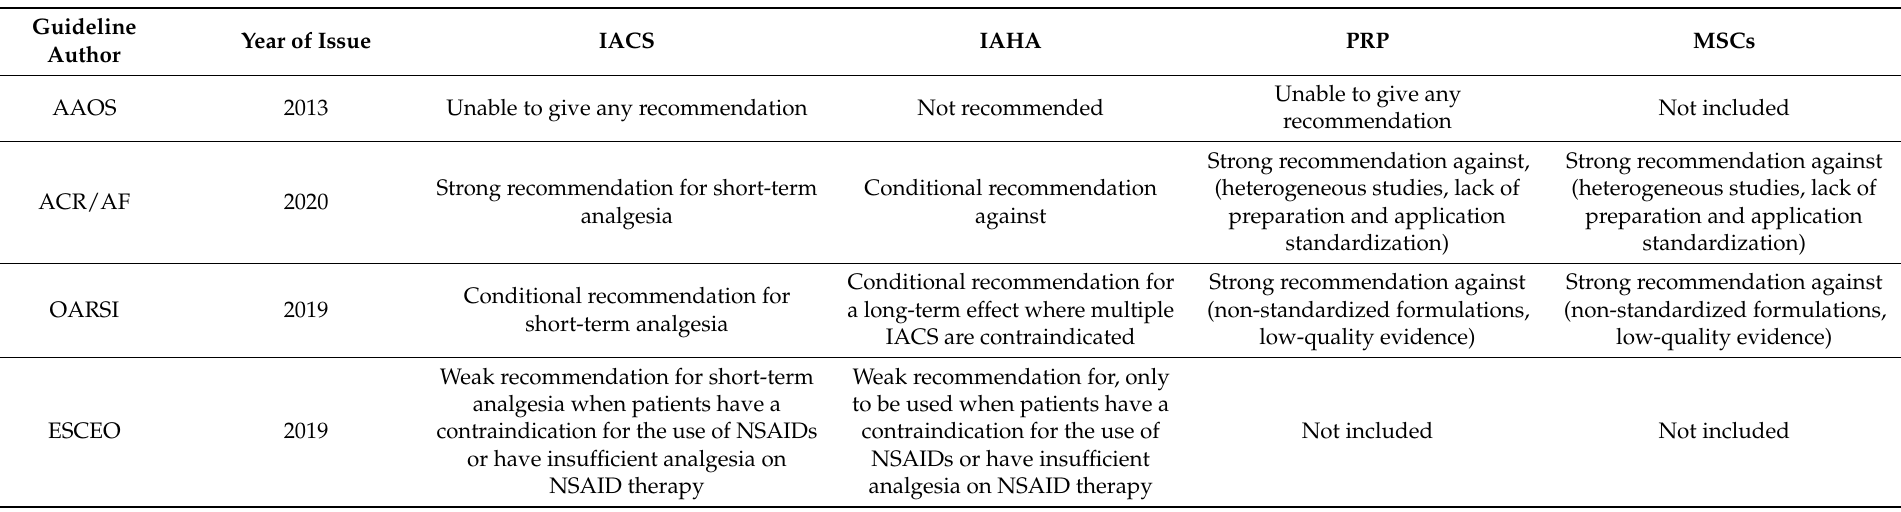
Table 2. Guideline recommendations for most commonly used intra-articular options in osteoarthritis